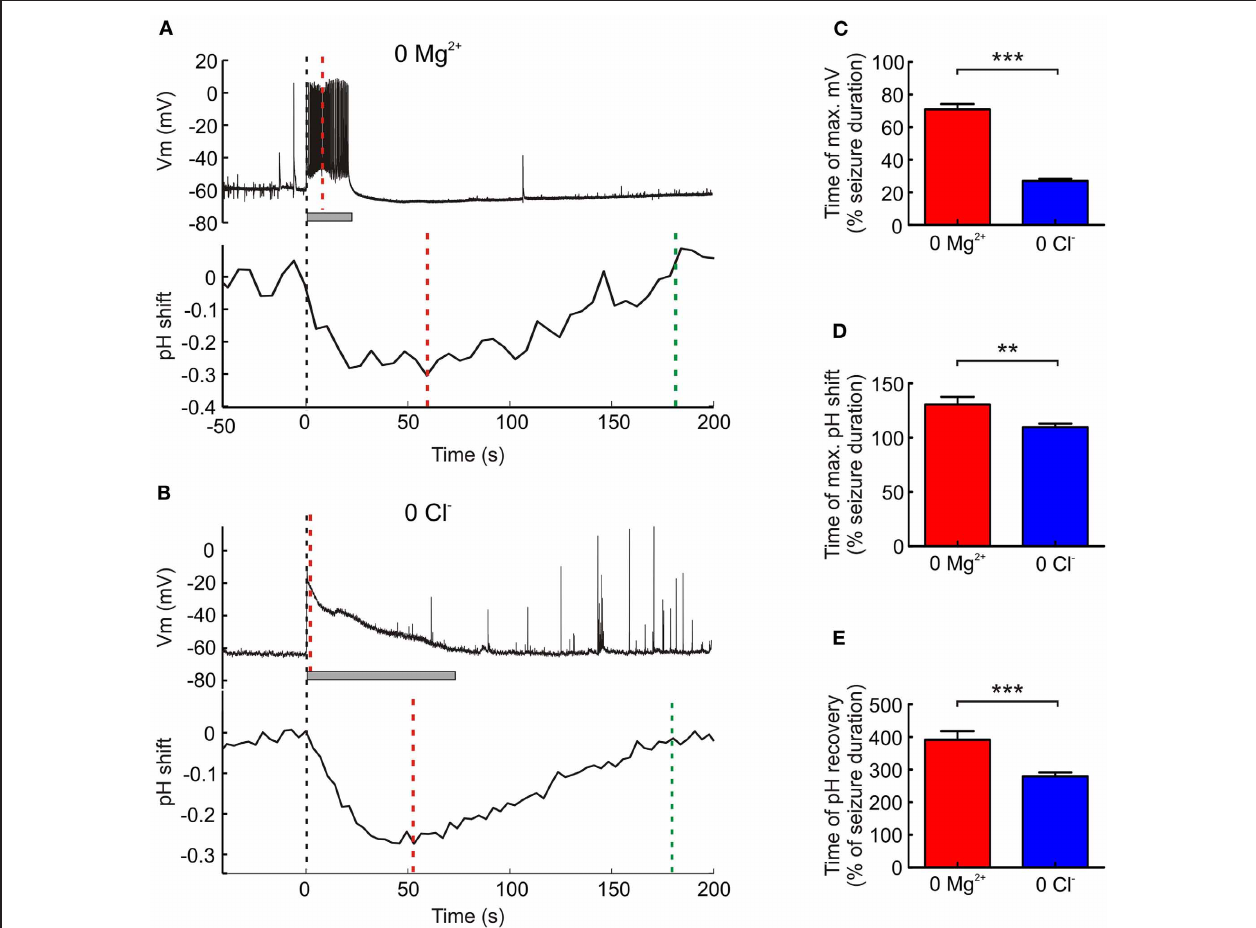
FIGURE 5 | The kinetics of acidic transients and epileptiform activity differ between seizure models. (A) The membrane potential (upper trace) of a hippocampal CA1 pyramidal neuron during a 0Mg 2 + induced seizure episode (seizure duration of 21s, indicated by the gray bar). The membrane potential reaches its maximum (red dashed line) midway through the seizure. Simultaneous recording of a neighboring pyramidal neuron’s intracellular pH (lower trace) reveals that this does not reach its minimum (red dashed line) until 35s after the seizure terminates and recovers (green dashed line) by approximately 160s following the end of the seizure. (B) The membrane potential (upper trace) of a CA1 pyramidal neuron during a 0Cl − induced seizure episode (seizure duration of 69s, indicated by the gray bar). Unlike the 0Mg 2 + induced seizure, the membrane potential reaches its peak (red dashed line) almost immediately after the seizure